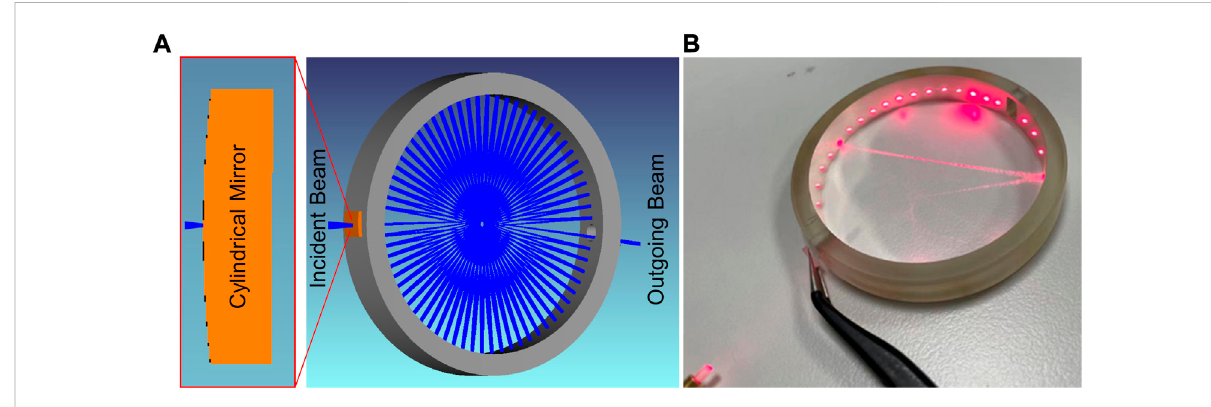
FIGURE 2 The micro circular absorption cell: (A) Optical path structure diagram; (B) Photograph.